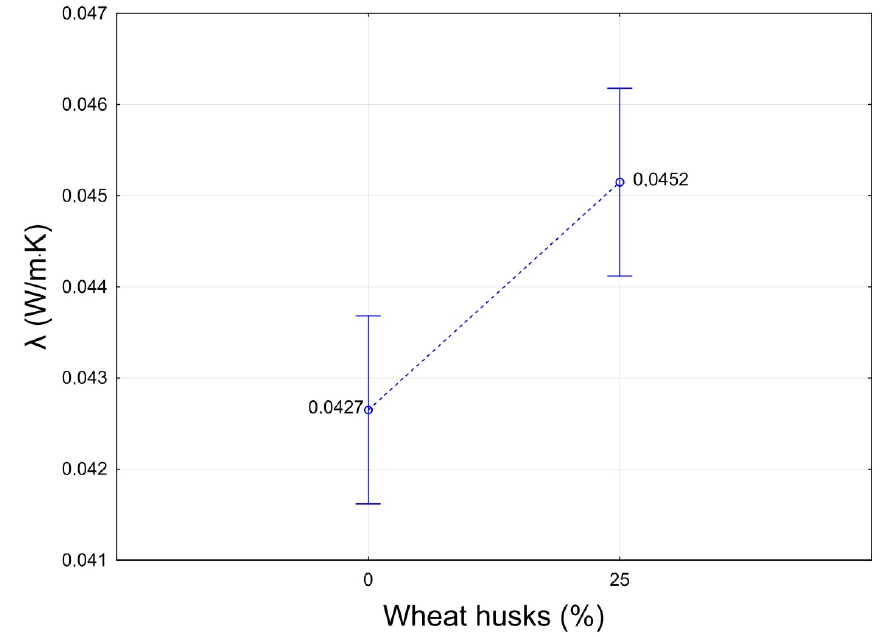
Figure 5. Influence of the proportion of the husk in the insulation board on the thermal conductivity coe ffi